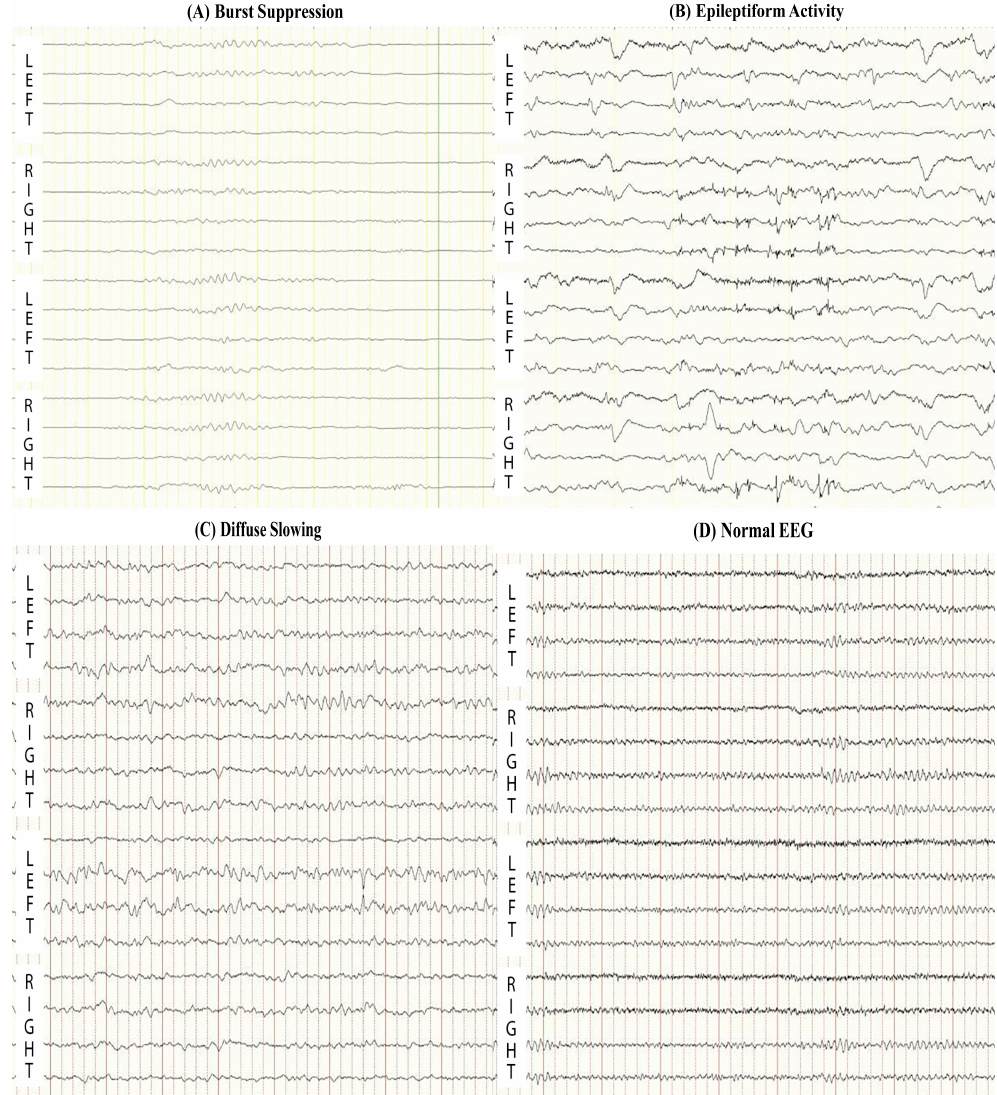
Figure 1. Representative abnormal electroencephalography (EEG) patterns: ( A ) Burst Suppression (the presence of bursts with amplitudes higher than 20 μ V, followed by the intervals of at least 1 s with suppression of EEG activity less than 20 μ V) and ( B ) Epileptiform Activity (including seizures and generalized periodic discharges) are associated with poor outcome; ( C ) Continuous Diffuse Slowing (EEG activity with a dominant frequency less than 8 Hz) and ( D ) Normal EEG at 12-h after resuscitation are associated with good outcome.